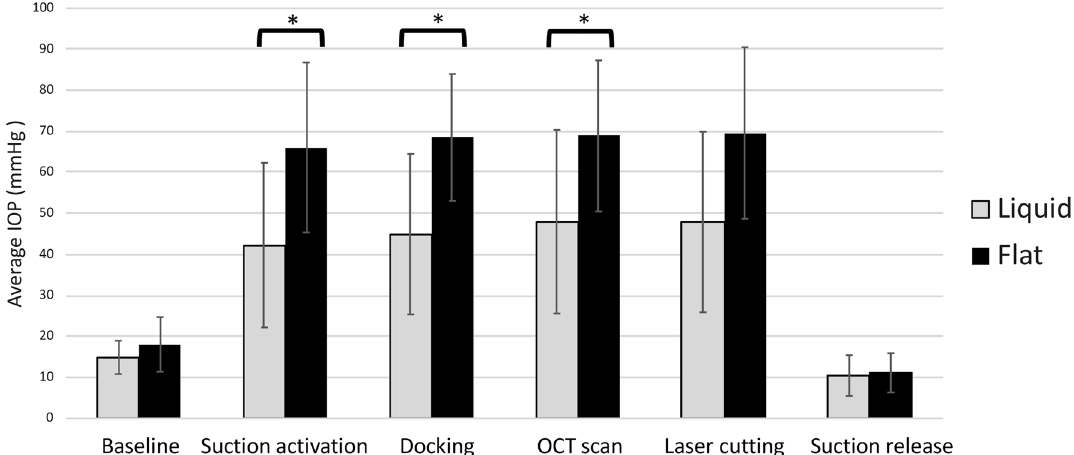
Figure 1. Mean IOP measurements during different phases of the laser trephination with both interfaces. * indicates P <